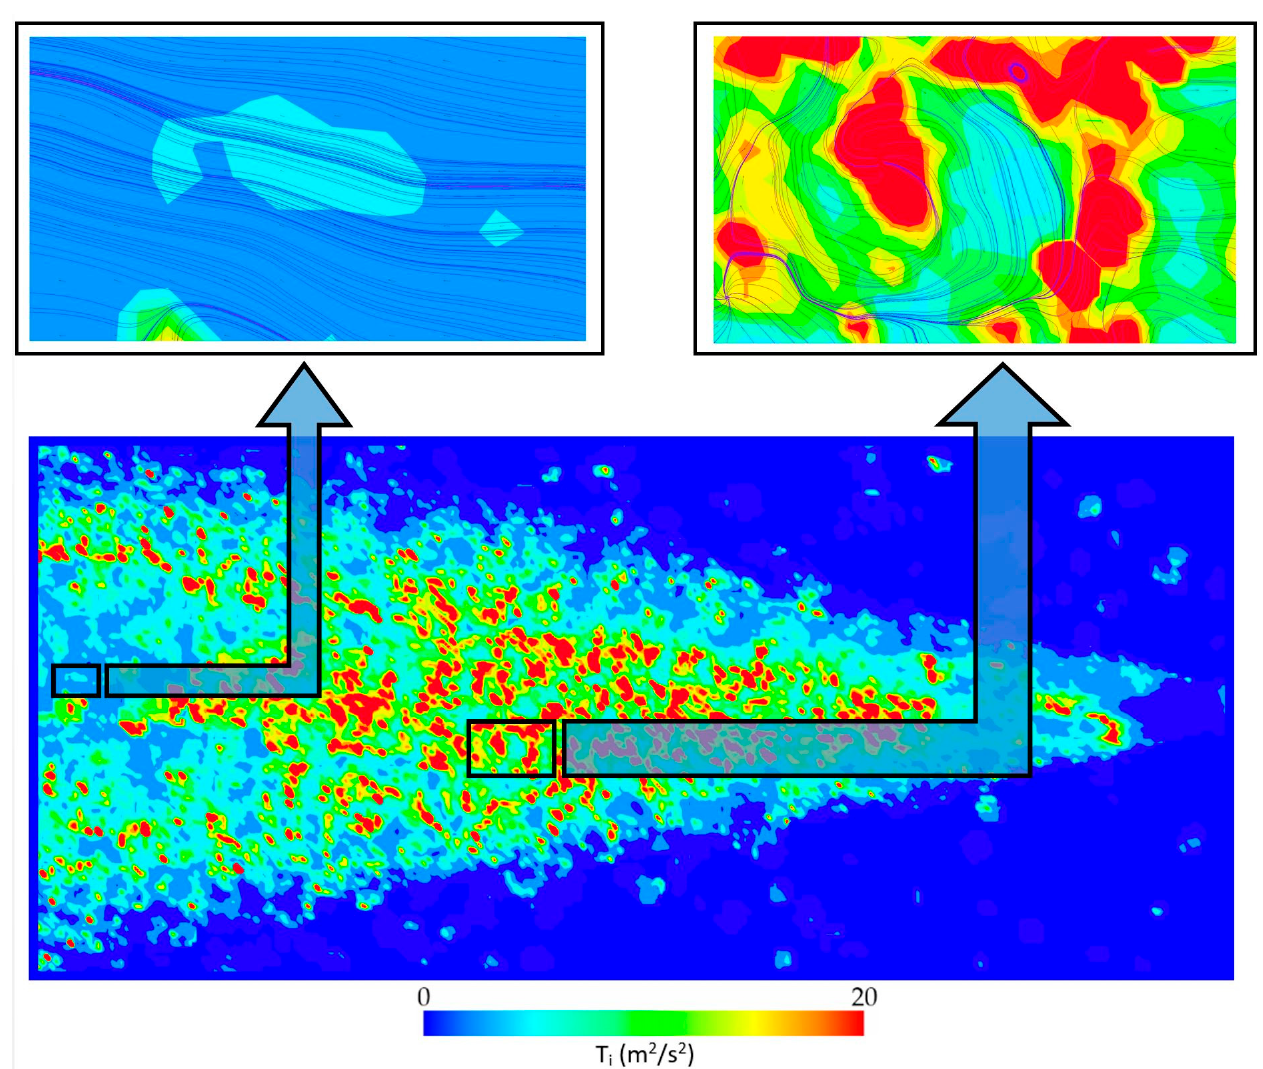
Figure 3. The idea of turbulent flow assessment using turbulent flow intensity factor T i. Velocity profiles were determined along the axis of symmetry of the nozzle over a section of 1 m from its outlet (excluding the already remarked initial 0.03 m sections due to the limitations of the measurement method). Additionally, auxiliary velocity profiles were plotted on the scalar velocity maps in the planes perpendicular to the main axis of the nozzle symmetry in the form of vectors visualizing the direction of the spray